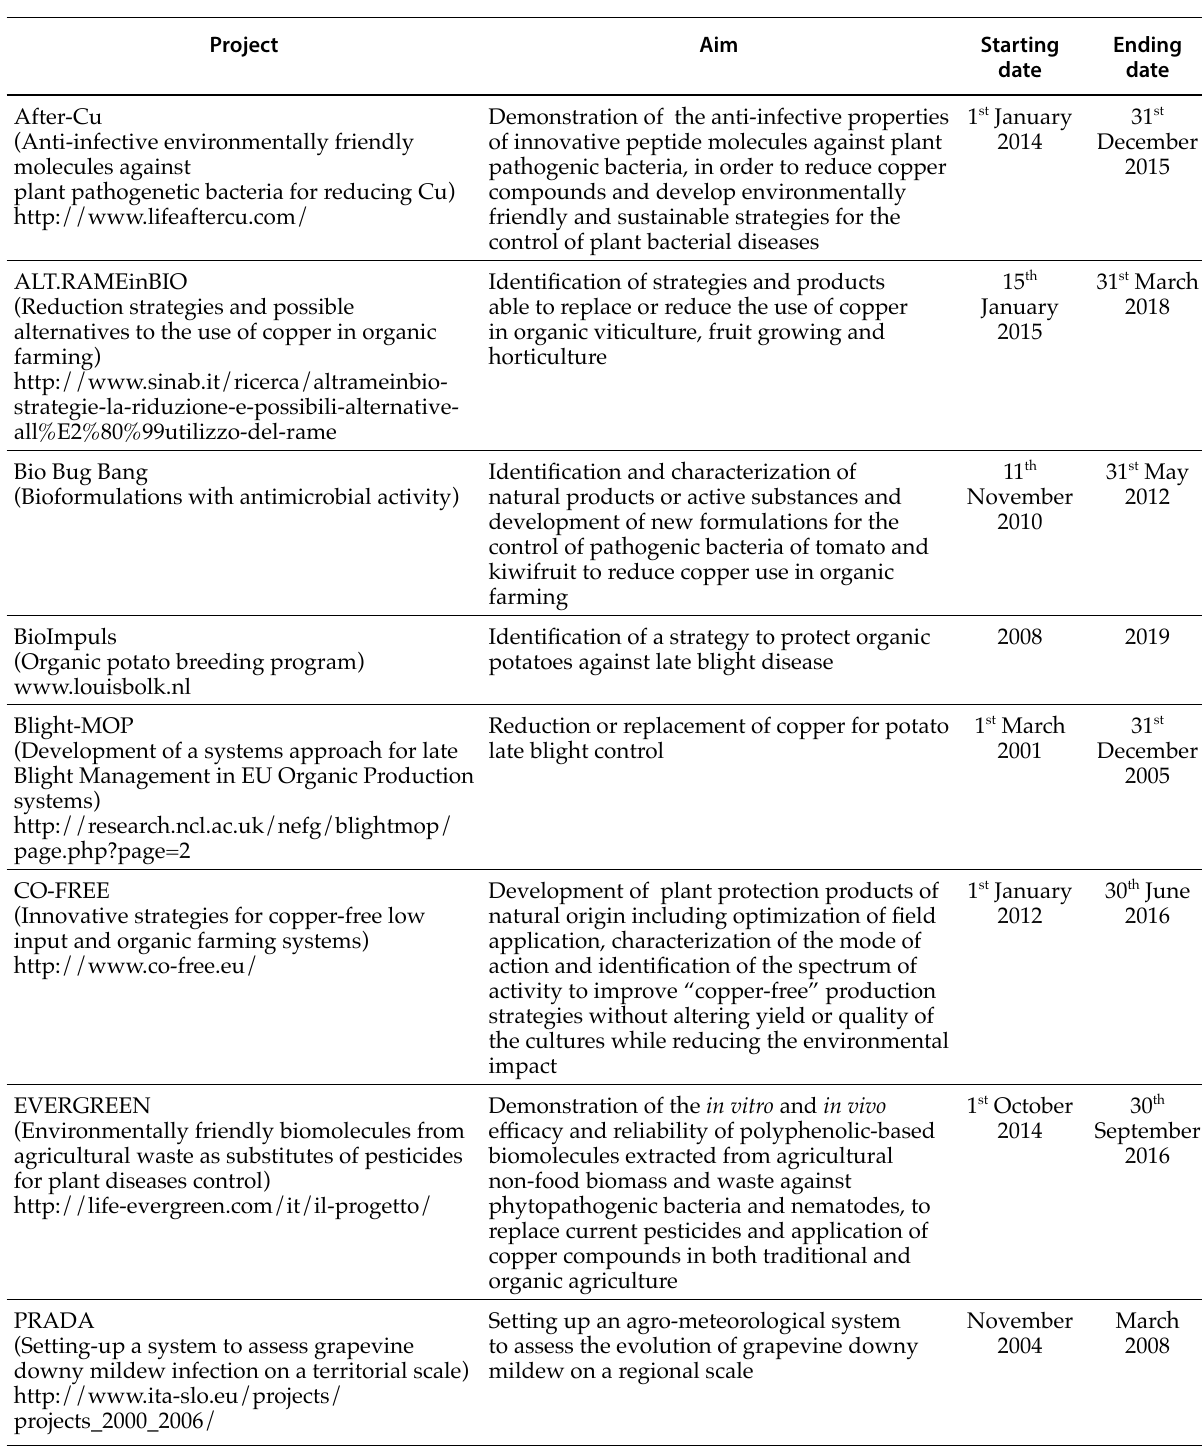
Table 4. List of the main research projects on copper-related issues.